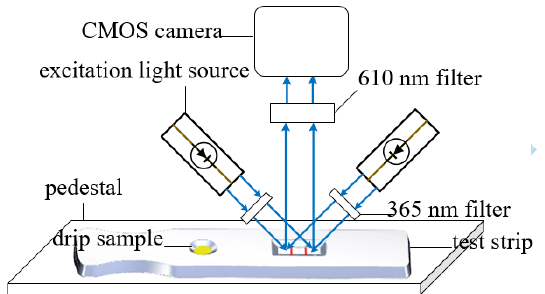
Figure 2. Image acquisition device of the fluorescence immunochromatographic assay (FICA) reader based on image processing.